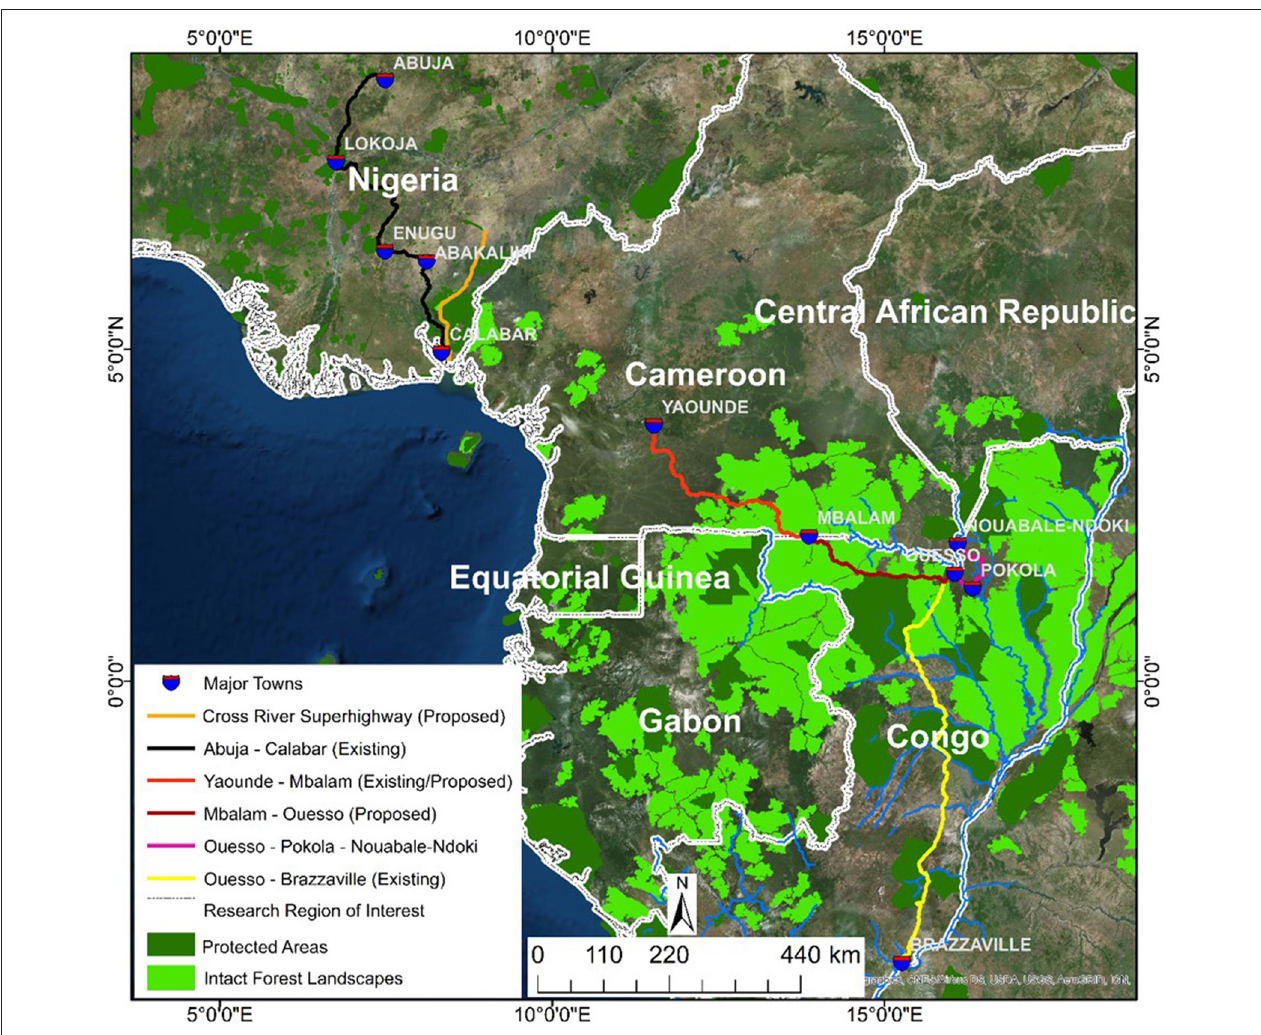
FIGURE 1 | Some of the proposed and existing highway routes in Equatorial Africa. The Cross River Superhighway in Nigeria (proposed). Yaounde-Mbalam (partly existing and proposed) Mbalam-Ouesso (proposed) and Ouesso-Brazzaville (existing). The protected areas layer was downloaded from the World Database on Protected Areas 2017 and Intact Forest Landscapes 2000 layer was acquired from the Global Forest Watch